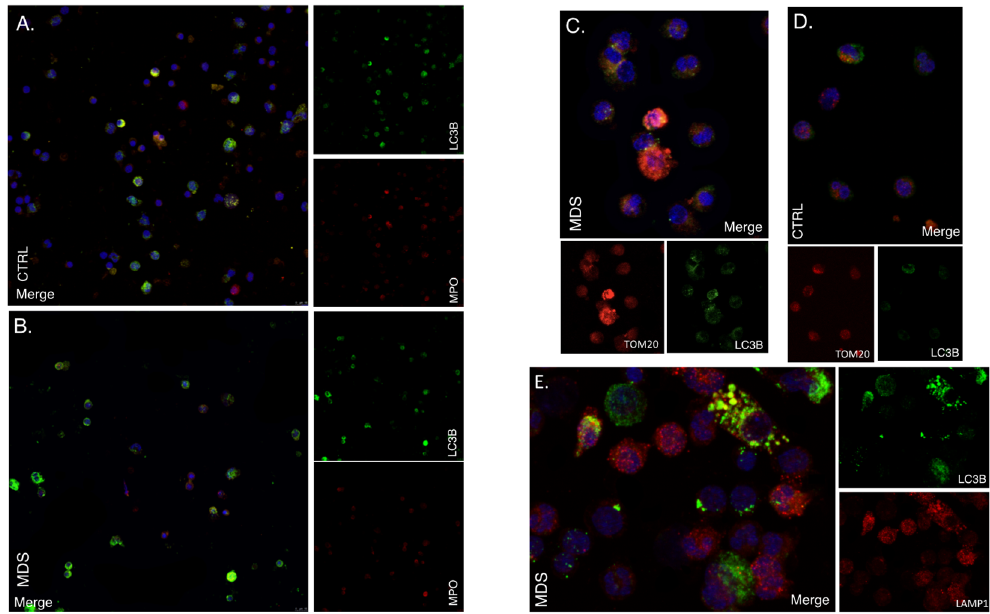
Figure 3. Autophagy is up-regulated in differentiating myeloid cells from MDS patients. ( A , B ) Autophagy levels in myeloid cells (high density layer) after density gradient separation, as assessed by LC3B immunofluorescence. Red: MPO, Green: LC3B, Blue: DAPI. Objective 63 × /1.4NA. One representative out of four independent experiments is shown. ( C , D ) Active mitophagy in myeloid cells from MDS patients and CTRL as assessed by LC3B/TOMM20 immunofluorescence Red: TOMM20, Green: LC3B, Blue: DAPI. Objective 63 × /1.4NA-representative close-up. One out of two independent experiments is shown. ( E ) Immunofluorescence of LC3B and LAMP-1 in myeloid cells of MDS patients. Objective 63 × /1.4NA representative close-up. Red: LAMP1, Green: LC3B, Blue: DAPI. One out of three independent experiments is shown. LC3B: Microtubule-associated proteins 1A/1B light chain 3B, MPO: Myeloperoxidase, TOMM20: Translocase Of Outer Mitochondrial Membrane 20, LAMP 1: Lysosomal-associated membrane protein 1.